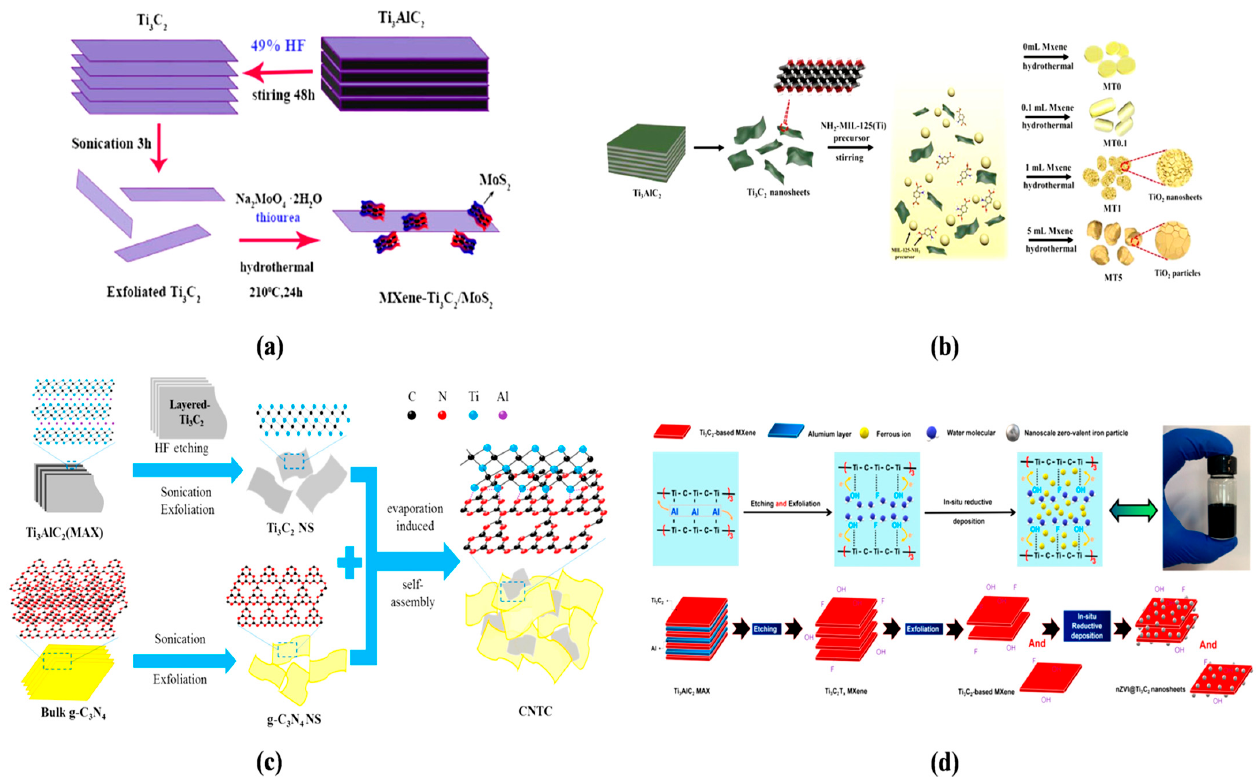
Figure 7. Graphic representation of the synthesis processes of ( a ) Ti 3 C 2 and MXene-Ti 3 C 2 /MoS 2 com- posites; ( b ) Ti 3 C 2 and heterostructure of MOFs; ( c ) CNTC photocatalyst by ultrasonic dispersion using an evaporation-induced self-assembly approach and combining HF etching; and ( d ) nZVI@Ti 3 C 2 . Reprinted with permission ( a ) from Ref. [127], ( b ) from Ref. [128], copyright (2020), ( c ) from Ref. [129], and ( d ) from Ref. [130].